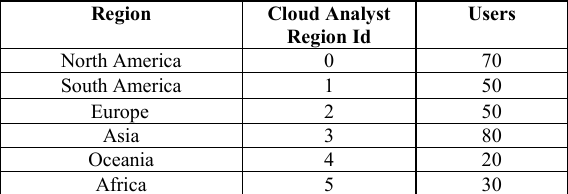
Table 2. Assumption of scale of user usage of the